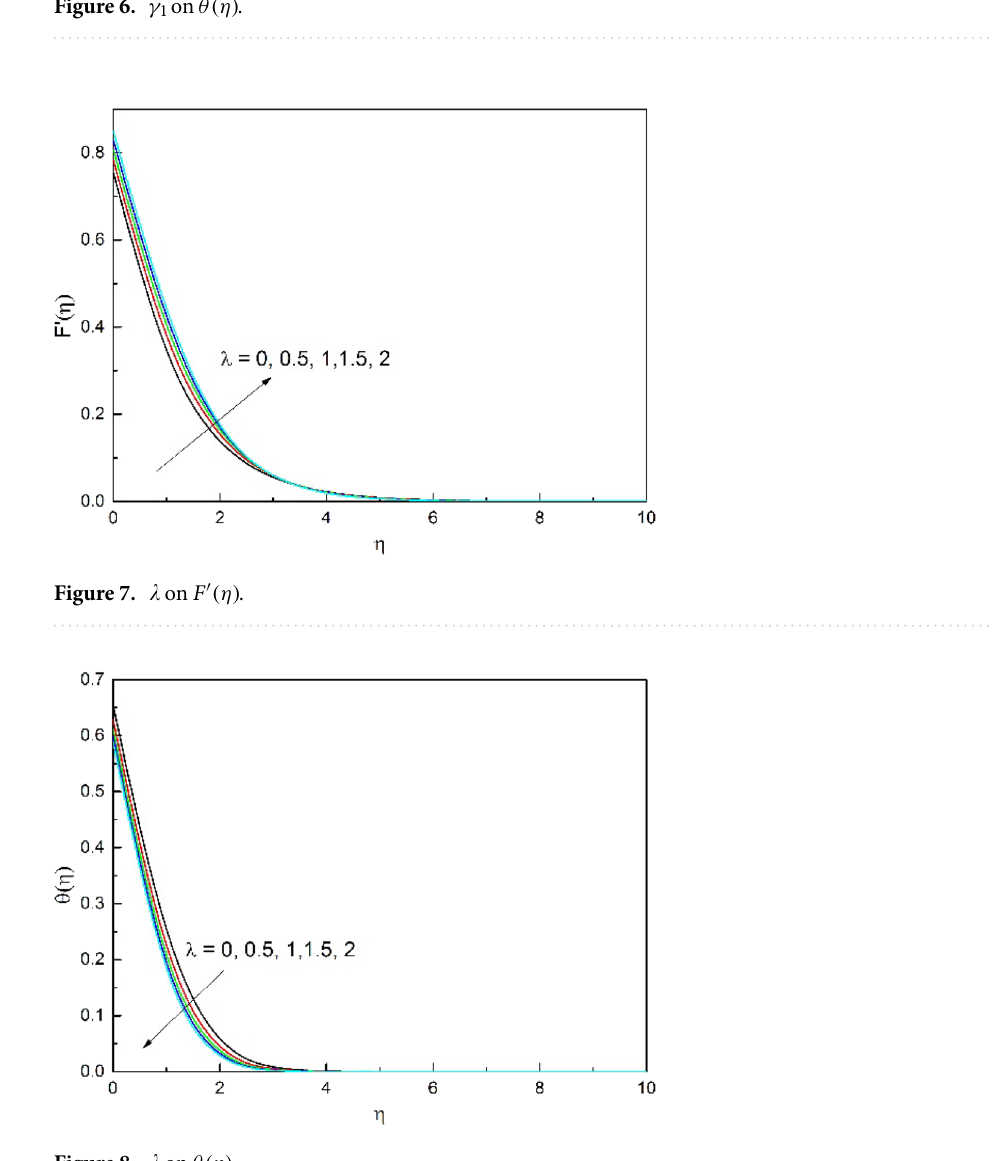
Figure 8. (cid:31) on θ(η)